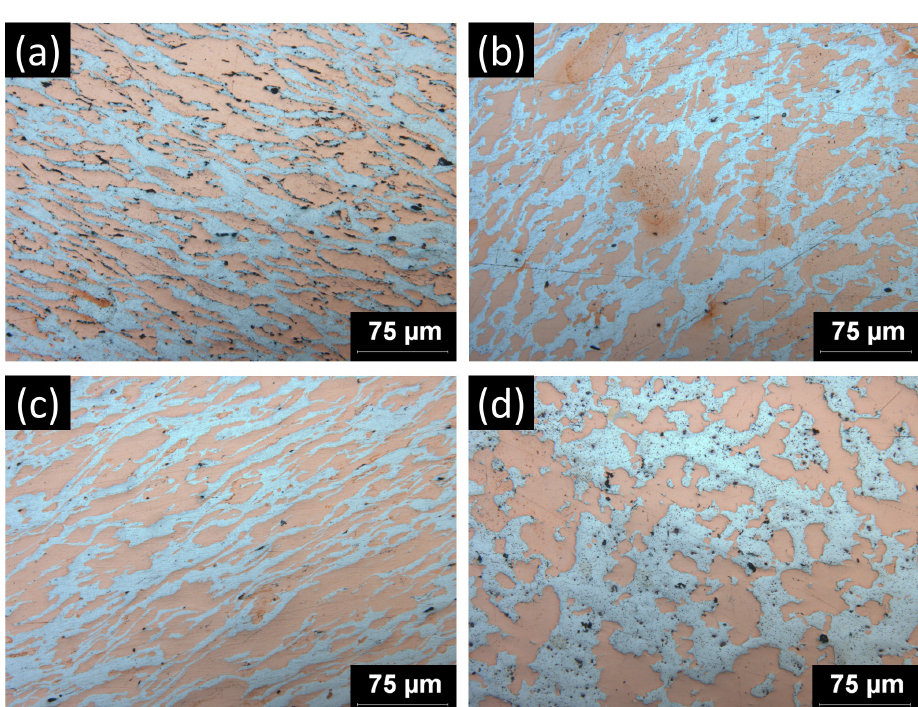
Figure 3. Optical microscopy micrographs for the samples obtained with 1 pass at RT (A), 4 passes at RT (B), 1 pass at CT (C) and by uniaxial pressing